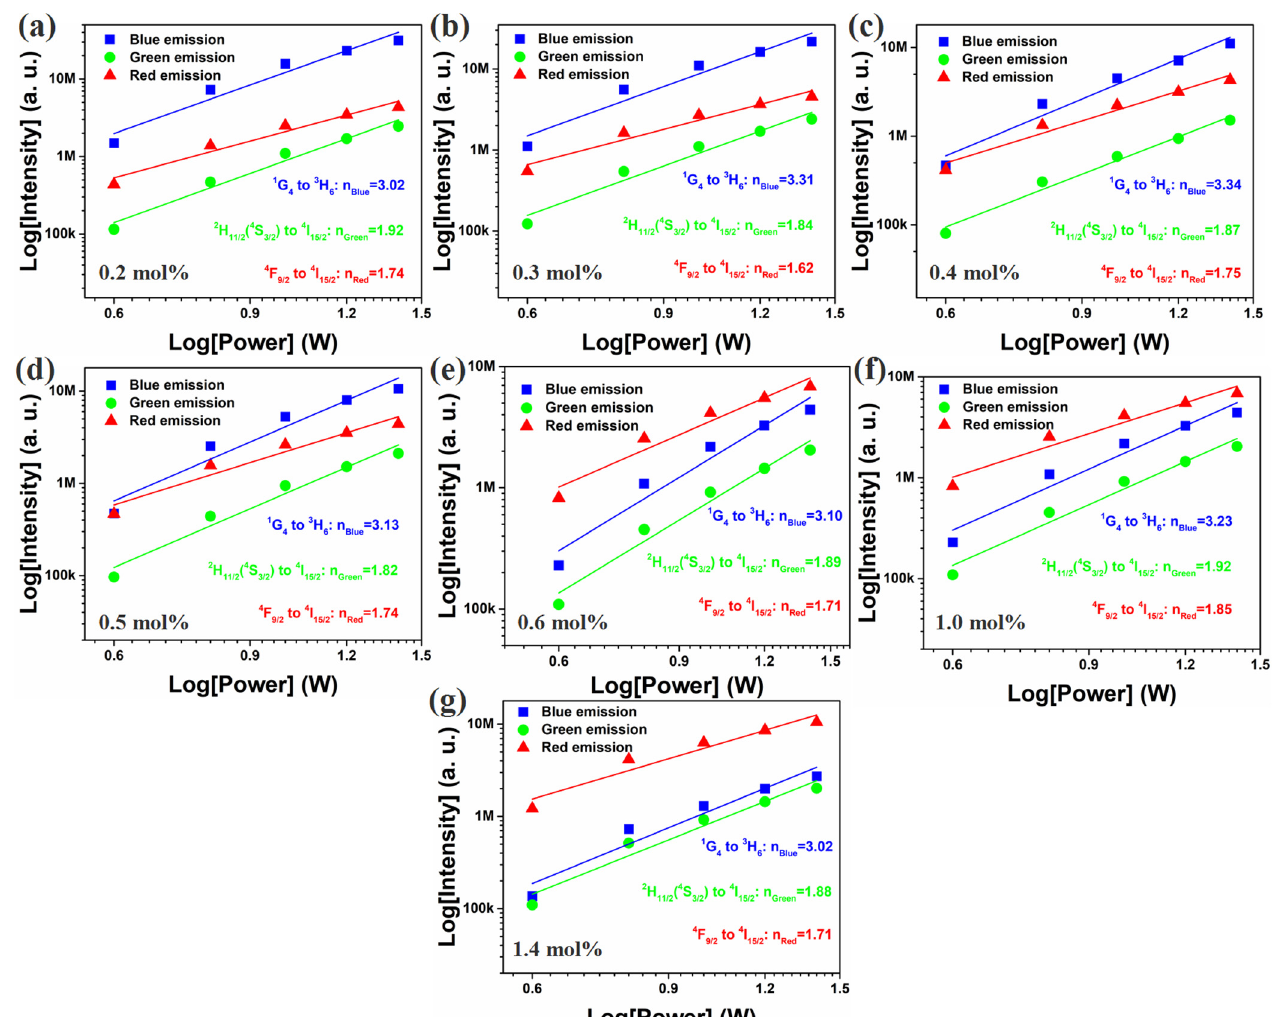
Figure 7. Log(emission intensity) plotted as functions of Log(laser diode pump power) for Y 2 O 3 - ZnO:Yb 3+ /Er 3+ /Tm 3+ -tridoped nano-phosphors (Er 3+ : 0.6 mol%); ( a ) Er 3+ : 0.2 mol%, ( b ) Er 3+ : 0.3 mol%, ( c ) Er 3+ : 0.4 mol%, ( d ) Er 3+ : 0.5 mol%, ( e ) Er 3+ : 0.6 mol%, ( f ) Er 3+ : 1.0 mol%, and ( g ) Er 3+ : 1.4 mol%.